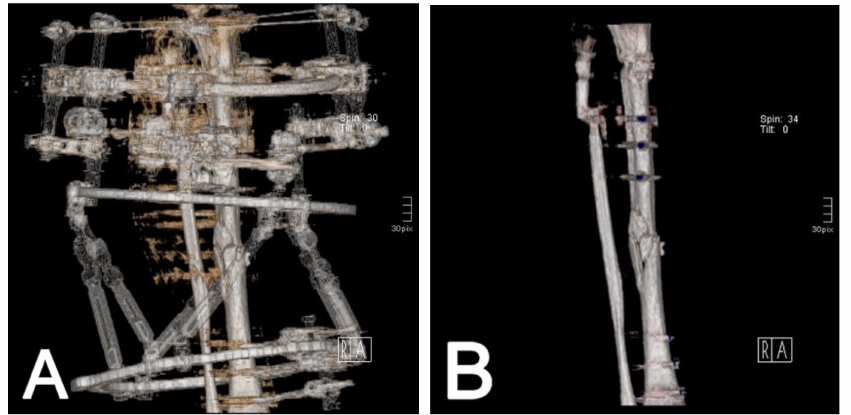
Figure 4. Three-dimensional reconstruction of the bone for planning. Artifacts and fixators can interfere with visibility in the region of interest ( A ) but can be removed by the software ( B